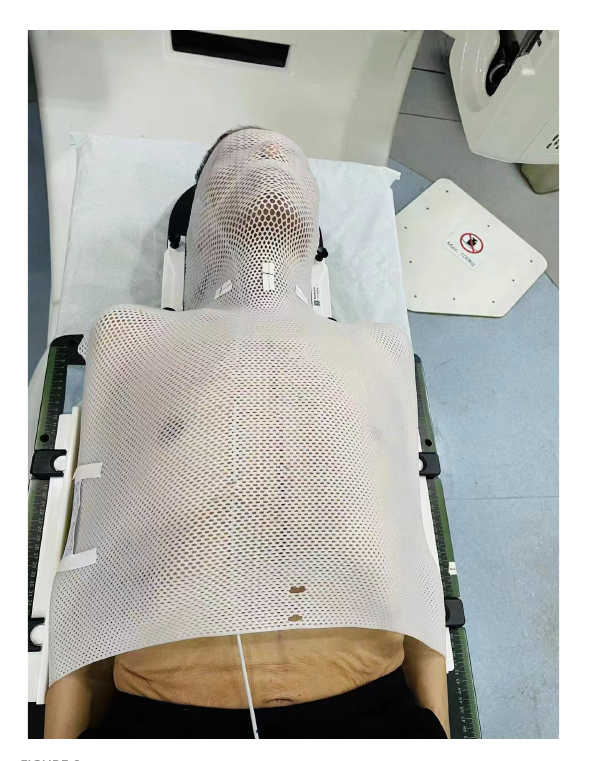
FIGURE 2 Illustration of the setup using the integrated cervicothoracic immobilization devices (ICTID) with arms on body